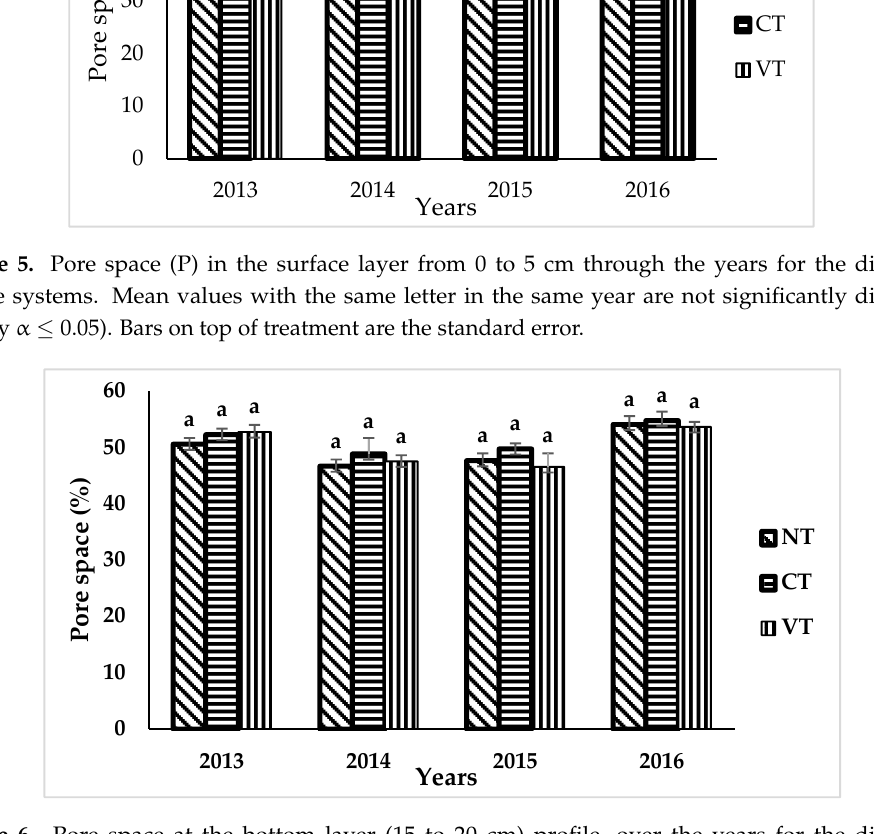
Figure 6. Pore space at the bottom layer (15 to 20 cm) profile, over the years for the different tillage systems. Mean values with the same letter in the same year are not significantly different (Tukey α ≤ 0.05). Bars on top of treatment are the standard error.